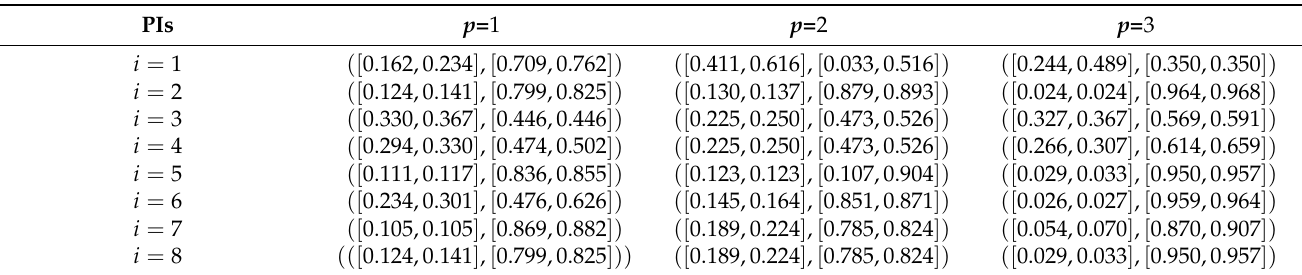
Table 8. The normalized fuzzy decision matrix.